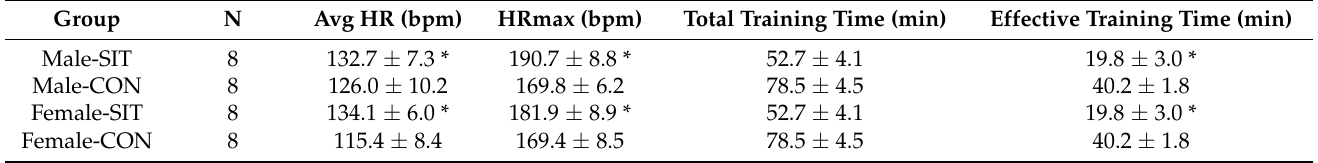
Table 4. Intensity monitoring during